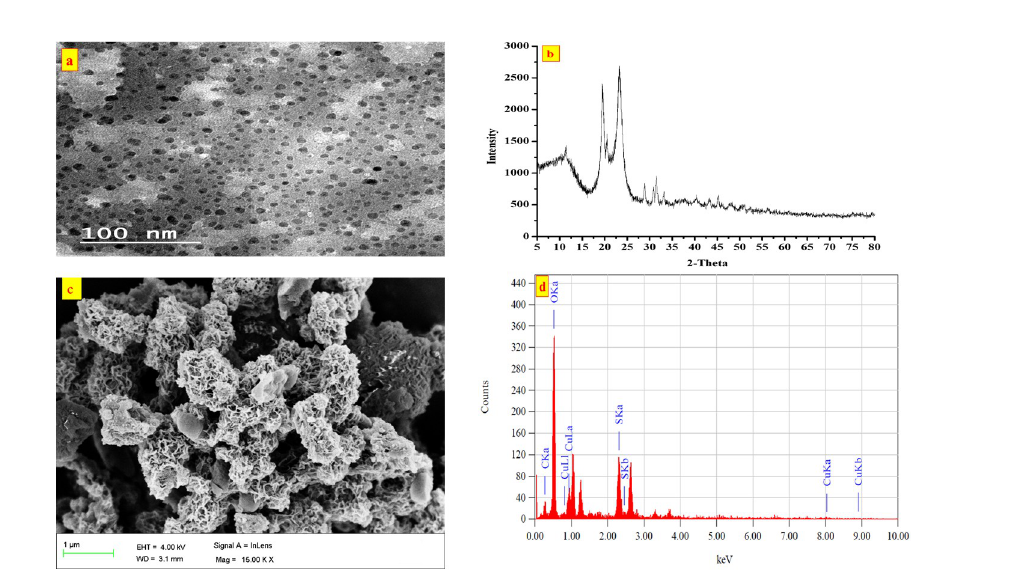
Fig 4. TEM image (a), XRD pattern (b), SEM image (c), EDX analysis (d) and of the biogenic Cu